Question: What visual encoding does this figure use to show its data?
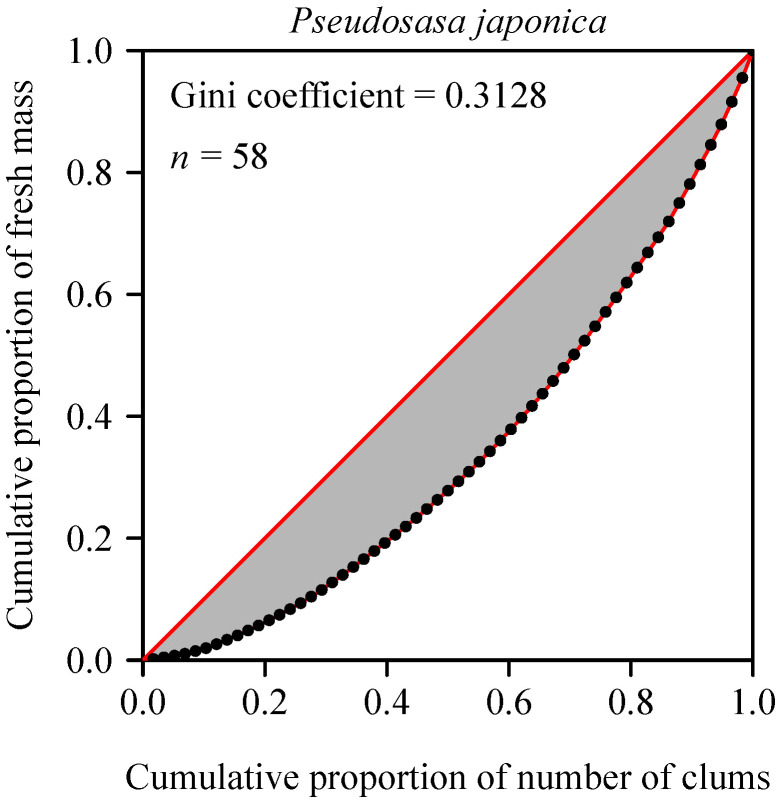
Answer: line